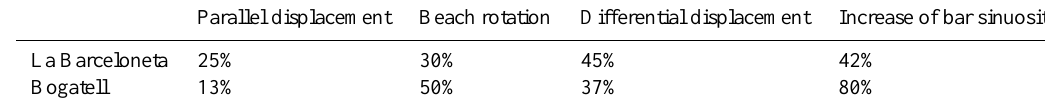
Table 1. Shoreline and bar response (%) with respect the total number of analyzed storms.